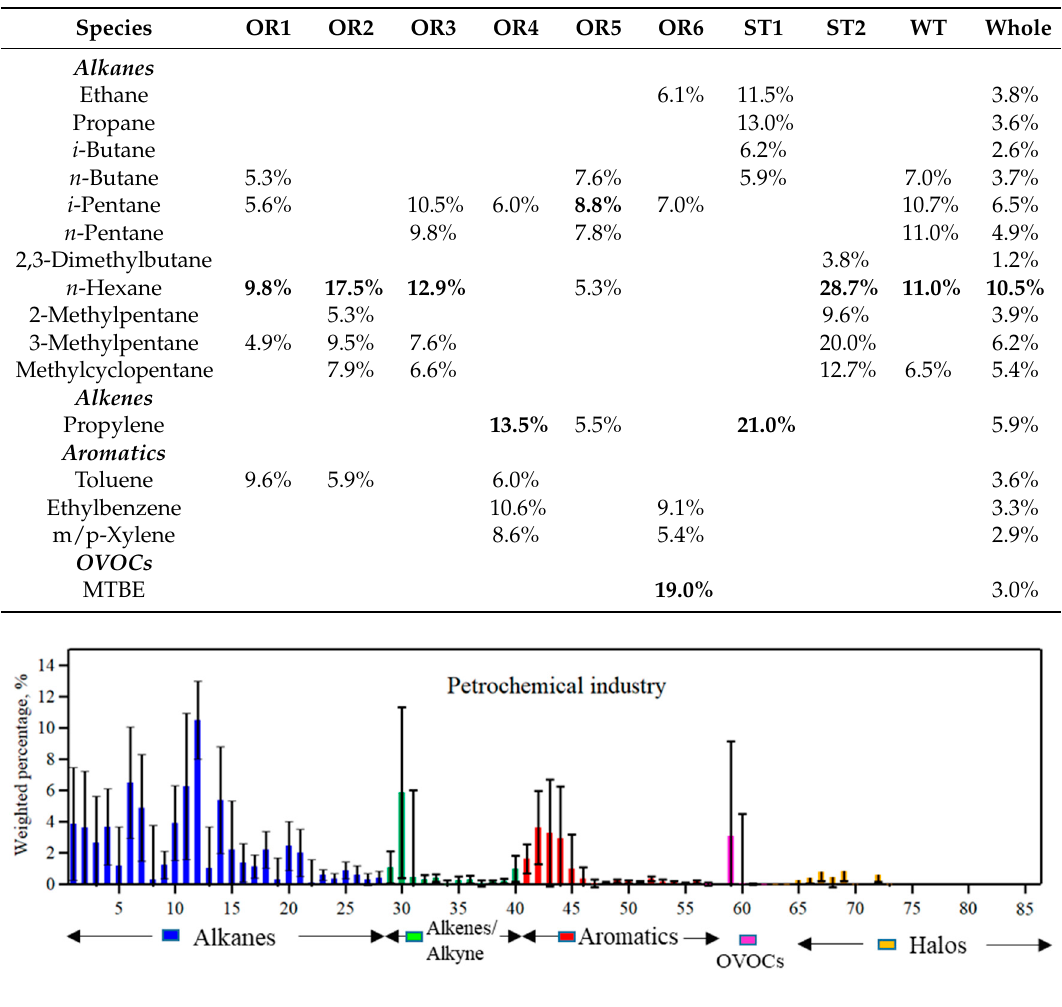
Figure 3. VOCs source profile for petrochemical industry.